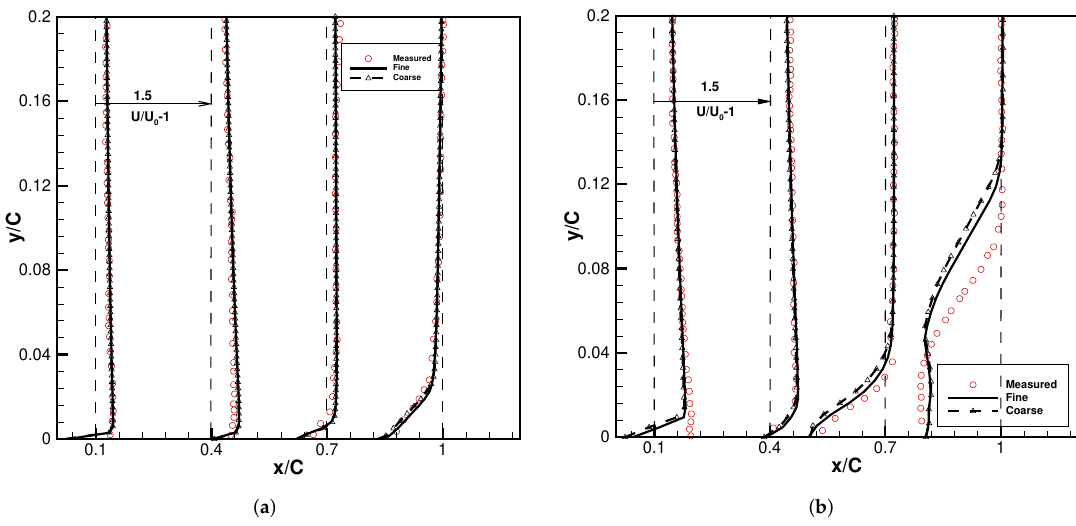
Figure 3. Grid independence study for angle of attack ( a ) 3 ◦ (case AOA3a) and ( b ) 9 ◦ (case AOA9a)